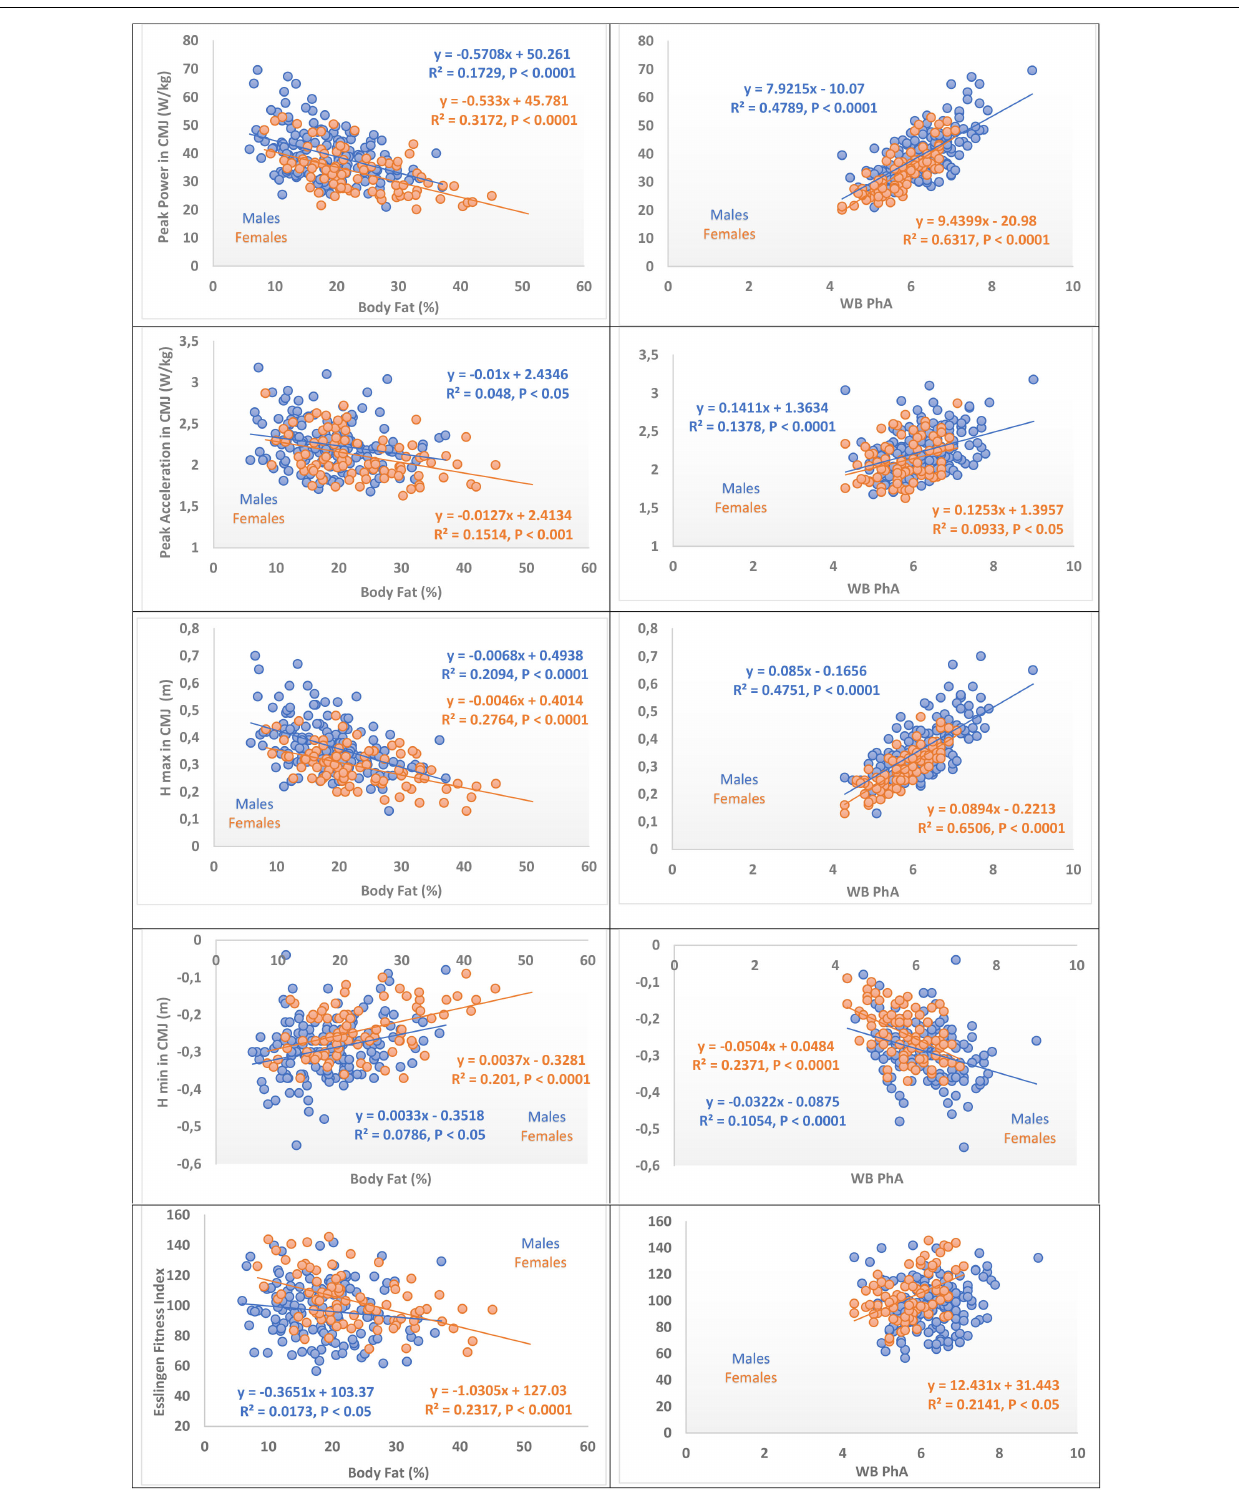
Frontiers in Physiology |